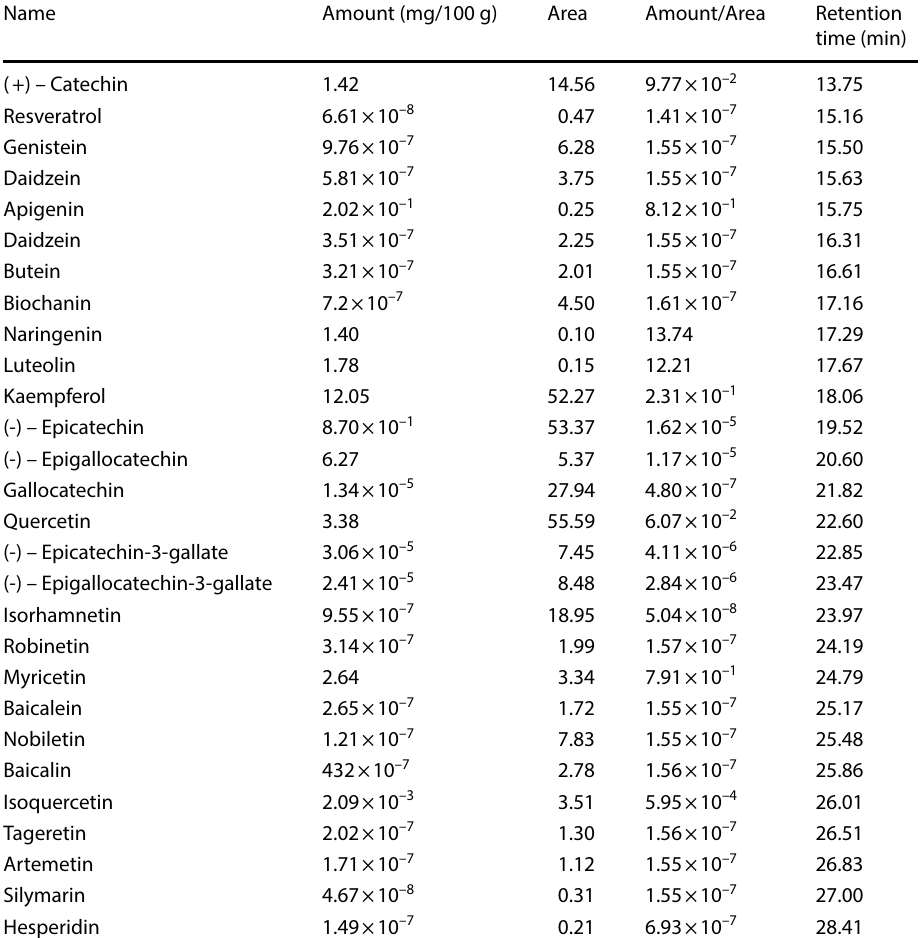
Table 4 Names and amount of the various flavonoids present in dichloromethane